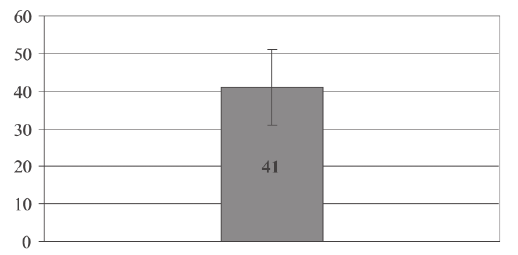
Figure 6 - Progression time (months) in patients with plasmacytoma that progressed to multiple myeloma (descriptive statistics)